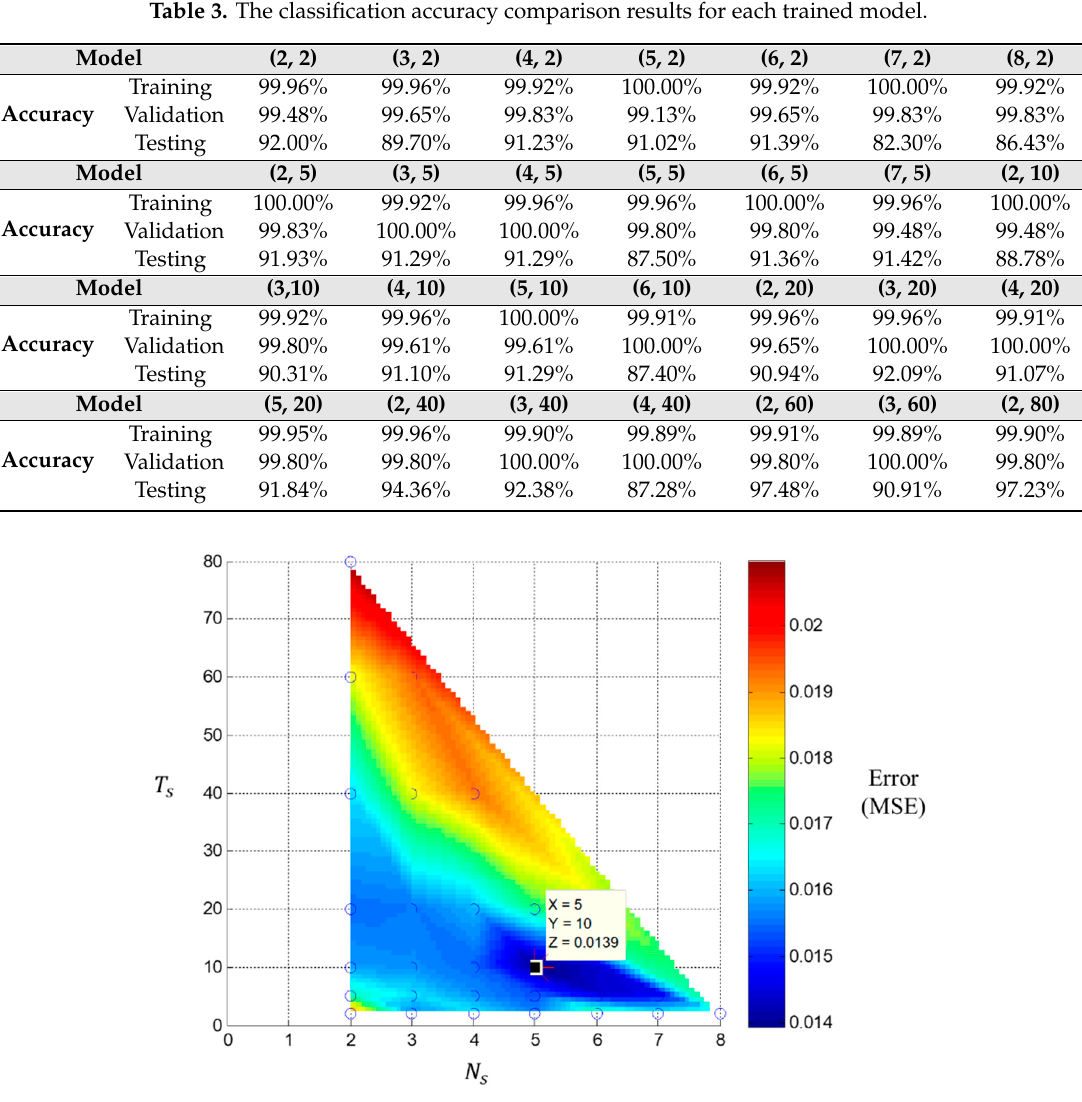
Table 3. The classification accuracy comparison results for each trained model.